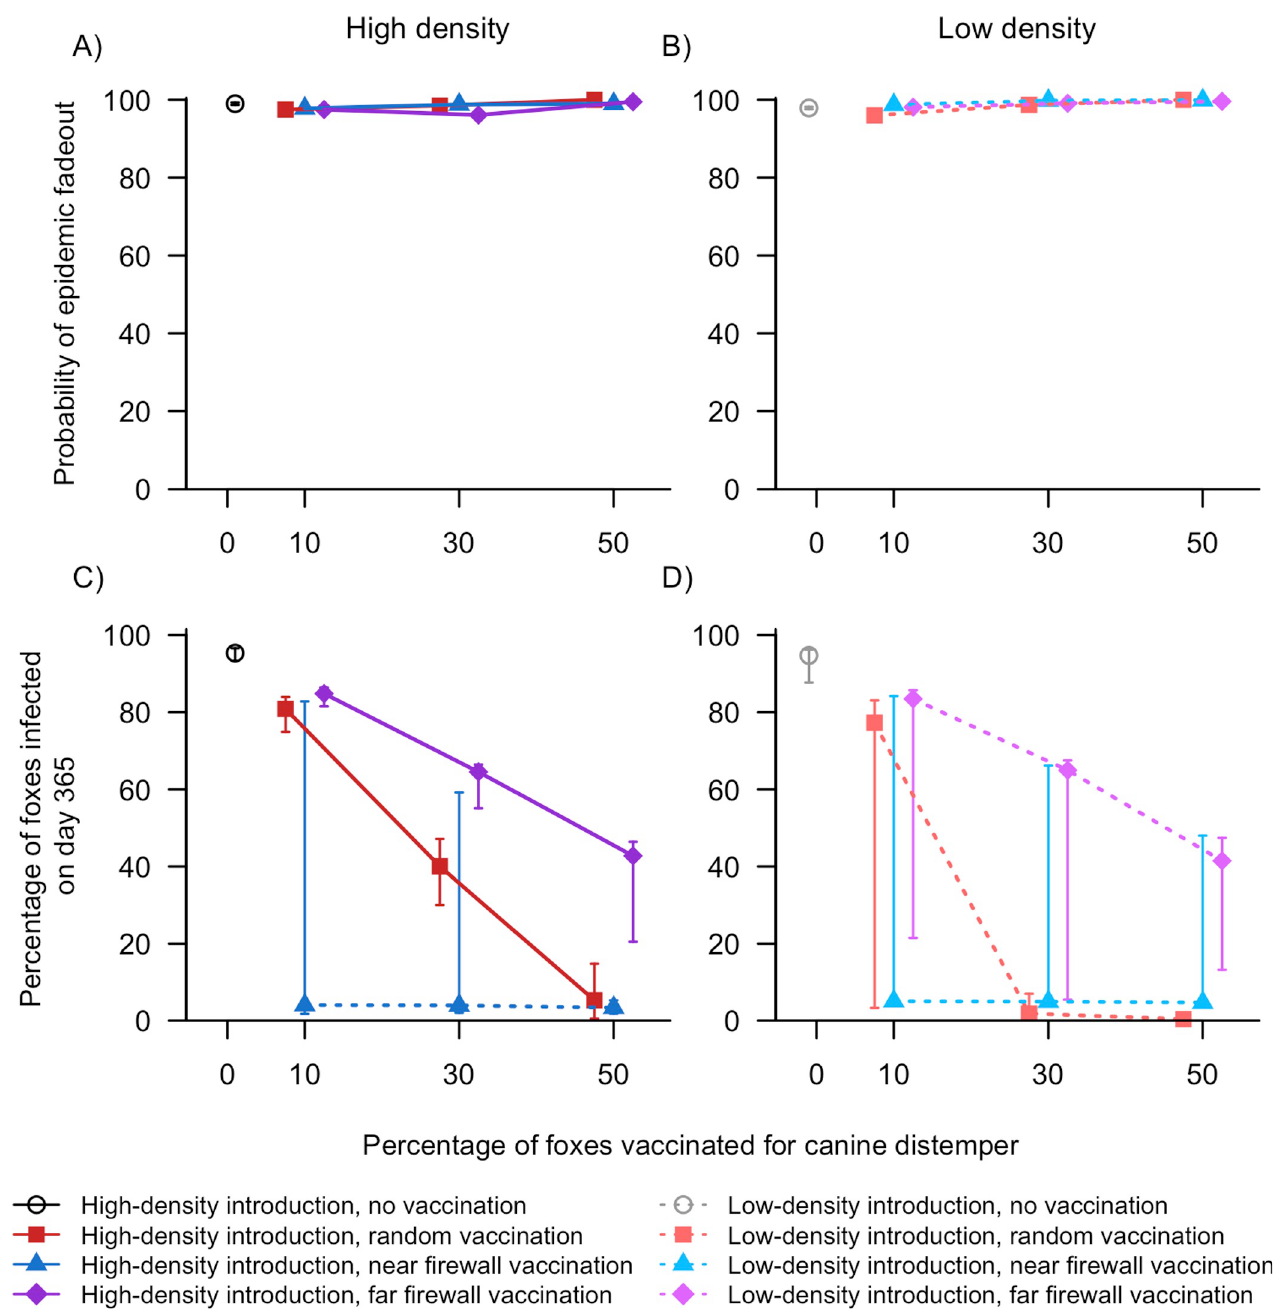
Fig 5. Model simulation results (medians, 25% and 75% quartiles) of canine distemper introduction to areas of San Clemente Island with high (A, C) or low (B, D) fox density and varying levels of fox vaccination (0%, 10%, 30%, or 50% of the population) distributed randomly or in a firewall. Simulations with firewall vaccination had either 5% of foxes (“near firewall”) or 20% of foxes (“far firewall”) on the side of the firewall where canine distemper was introduced. As the percentage of vaccinated foxes increased, the probability of epidemic fadeout (A, B) generally remained stable and the percentage of foxes infected (i.e. latent, infectious, or dead) by the end of the 365-day simulation (C, D) generally decreased. https://doi.org/10.1371/journal.pone.0232705.g005 of the simulation (Figs 5C and S2A and S5 Table). Near firewall vaccination was by far the most successful vaccine distribution, with a median of � 4.0% of foxes infected across all levels of vaccination (Figs 5C and S2C and S5 Table). However, there was high model variability